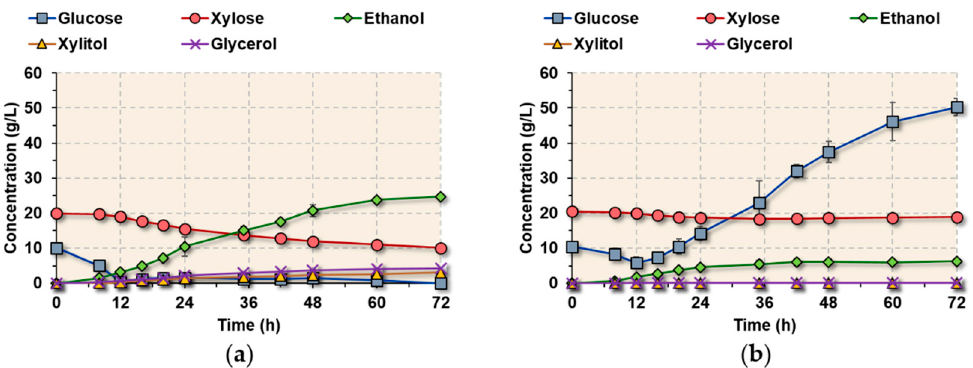
Figure 6. Time course of the batch fermentation of synthetic medium simulating an SSF process. Assays were performed with ( a ) C. intermedia CBS 141442 and ( b ) S. stipitis CBS 6054 as fermentative microorganisms. Synthetic medium containing 200 g / L glucose and 20 g / L xylose was added continuously between 12 and 60 h of fermentation at a flow rate of 3 mL / h. Values were calculated from three independent cultivations and the error bars indicate the standard deviations.